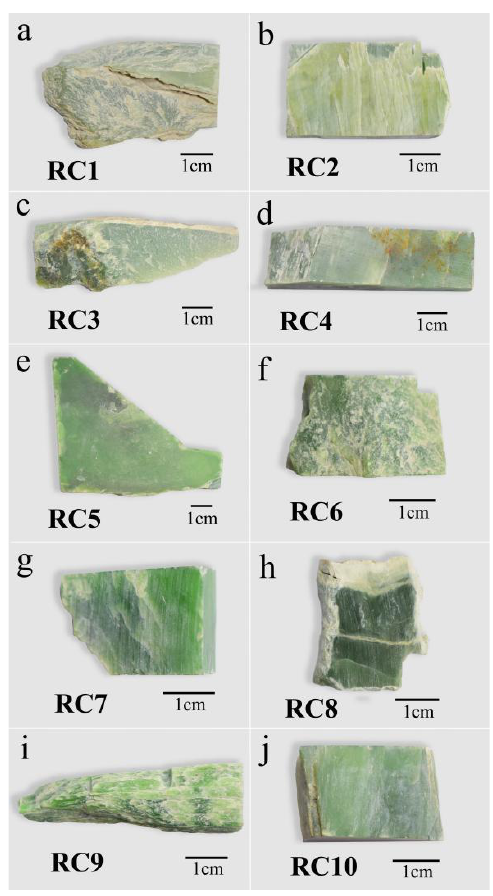
Figure 2. Chatoyant green nephrite samples from Ospinsk, Russia. ( a ) RC1. ( b ) RC2. ( c ) RC3. ( d ) RC4. ( e ) RC5. ( f ) RC6. ( g ) RC7. ( h ) RC8. ( i ) RC9. ( j ) RC10.